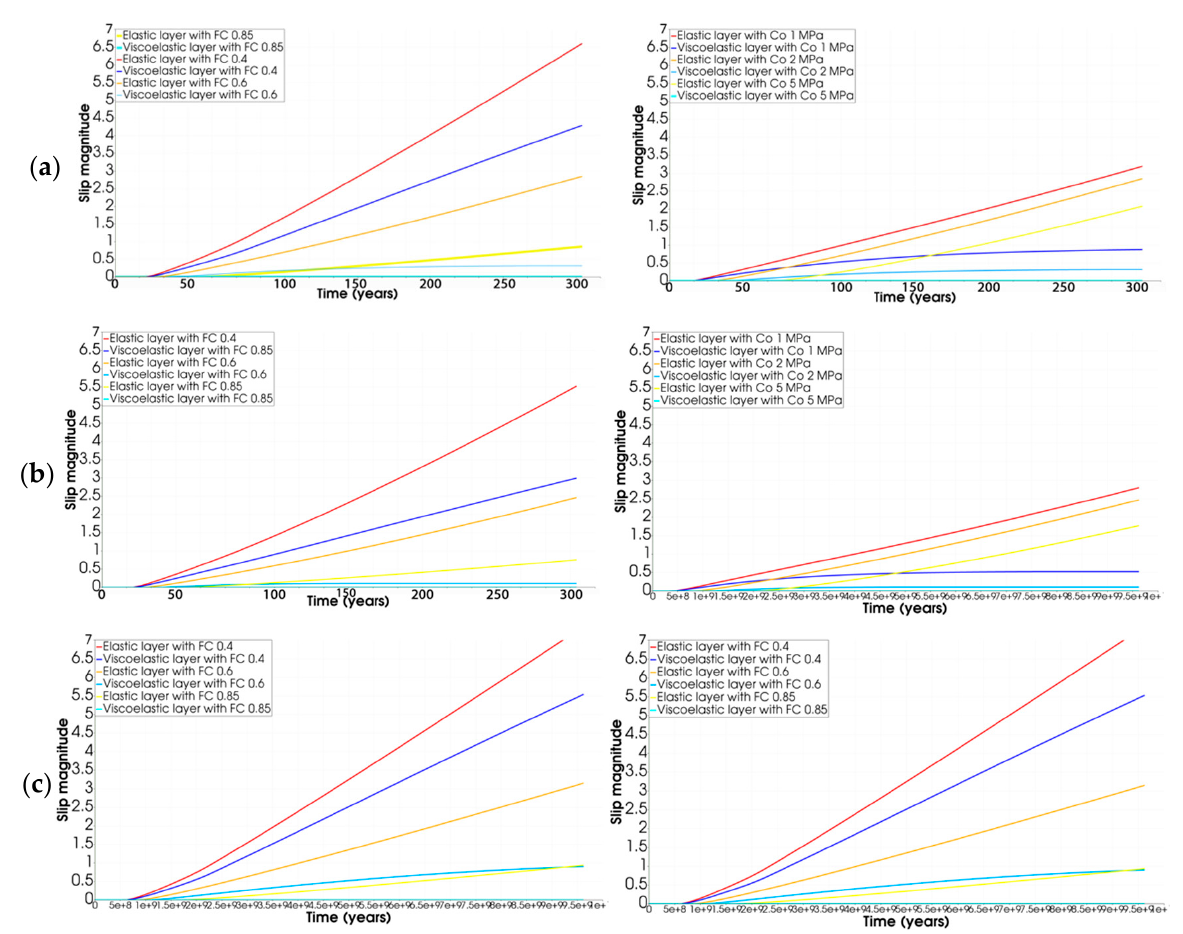
Figure 4. Displacement with distance from the fault of strain buildup model at year 250 based on different friction coefficients and cohesion values in three scenarios: ( a ) scenario one, ( b ) scenario two, and ( c ) scenario three.